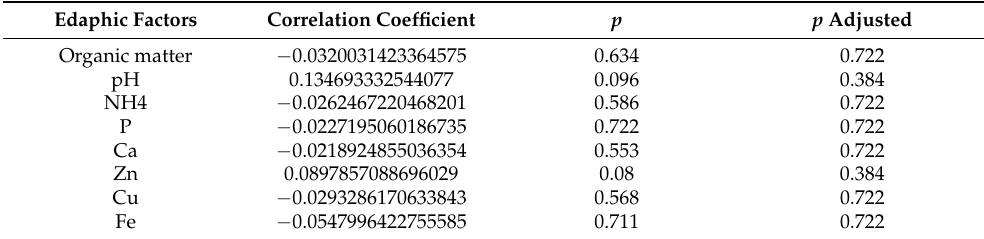
Table A5. A Mantel test of soil edaphic factors and soil fungal community